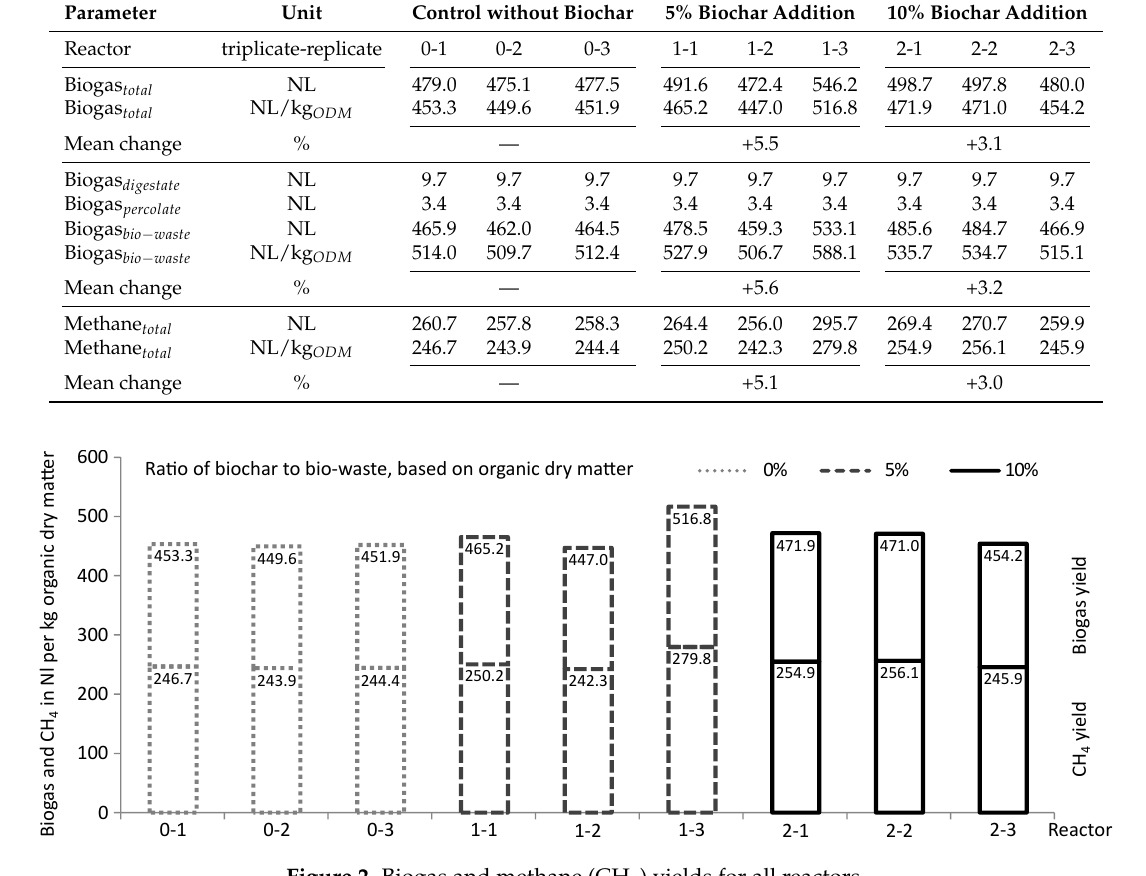
Figure 2. Biogas and methane (CH 4 ) yields for all